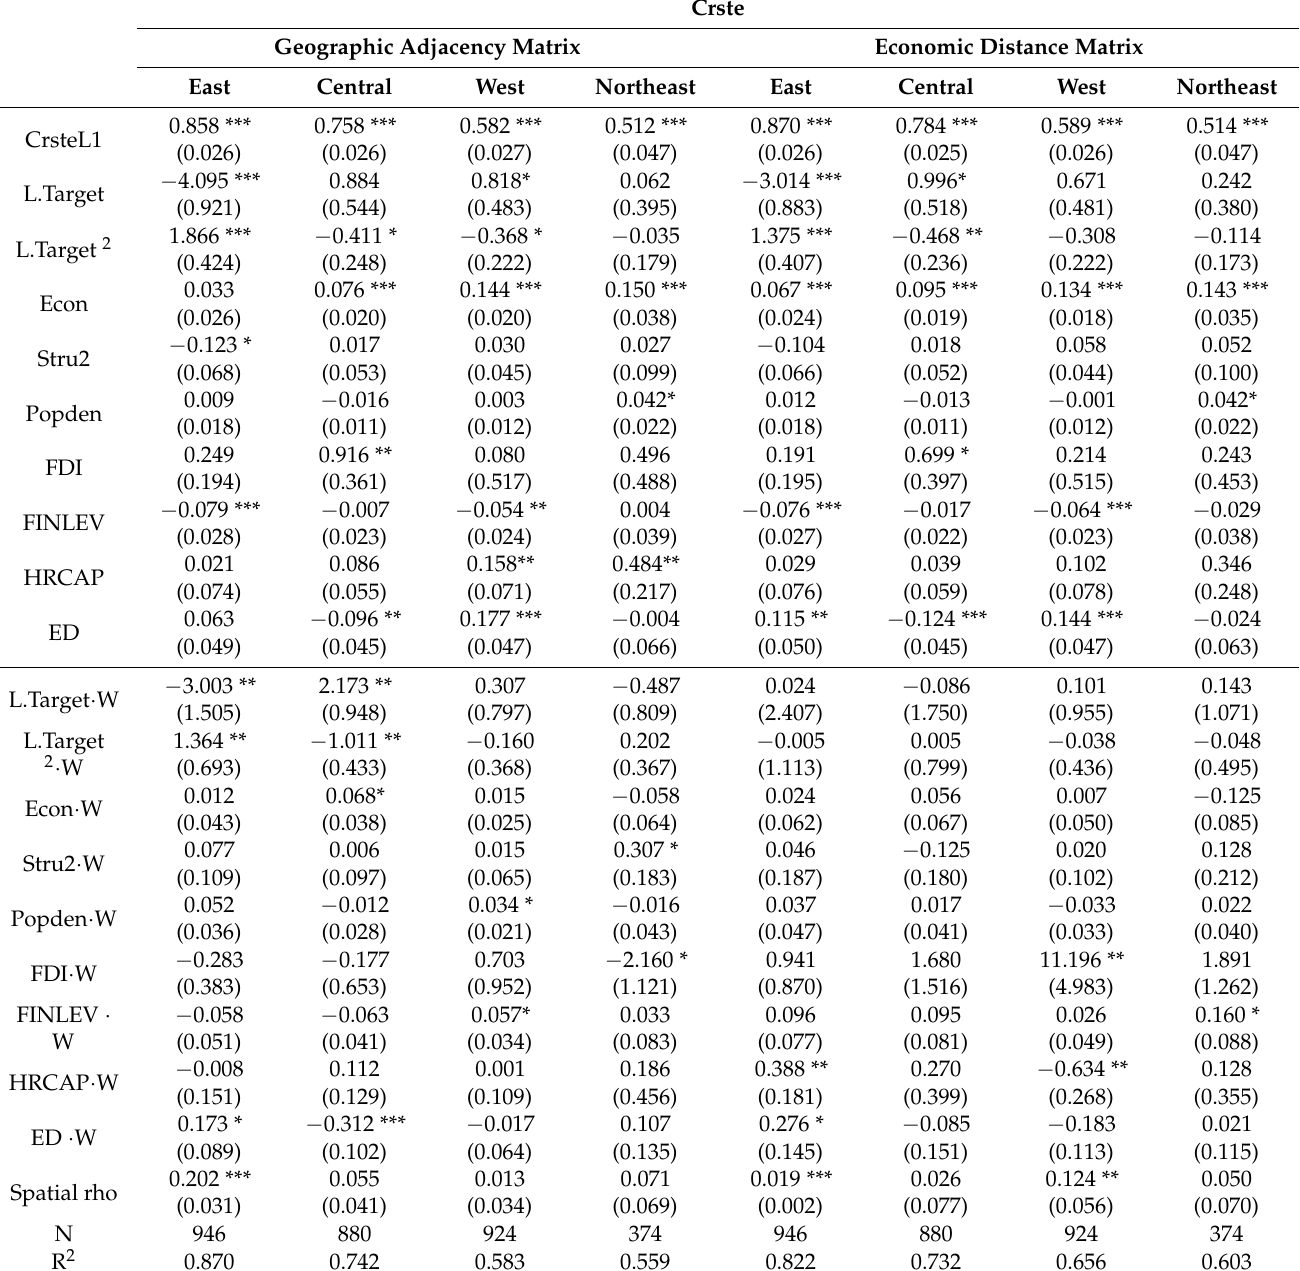
Table 6. Heterogeneity